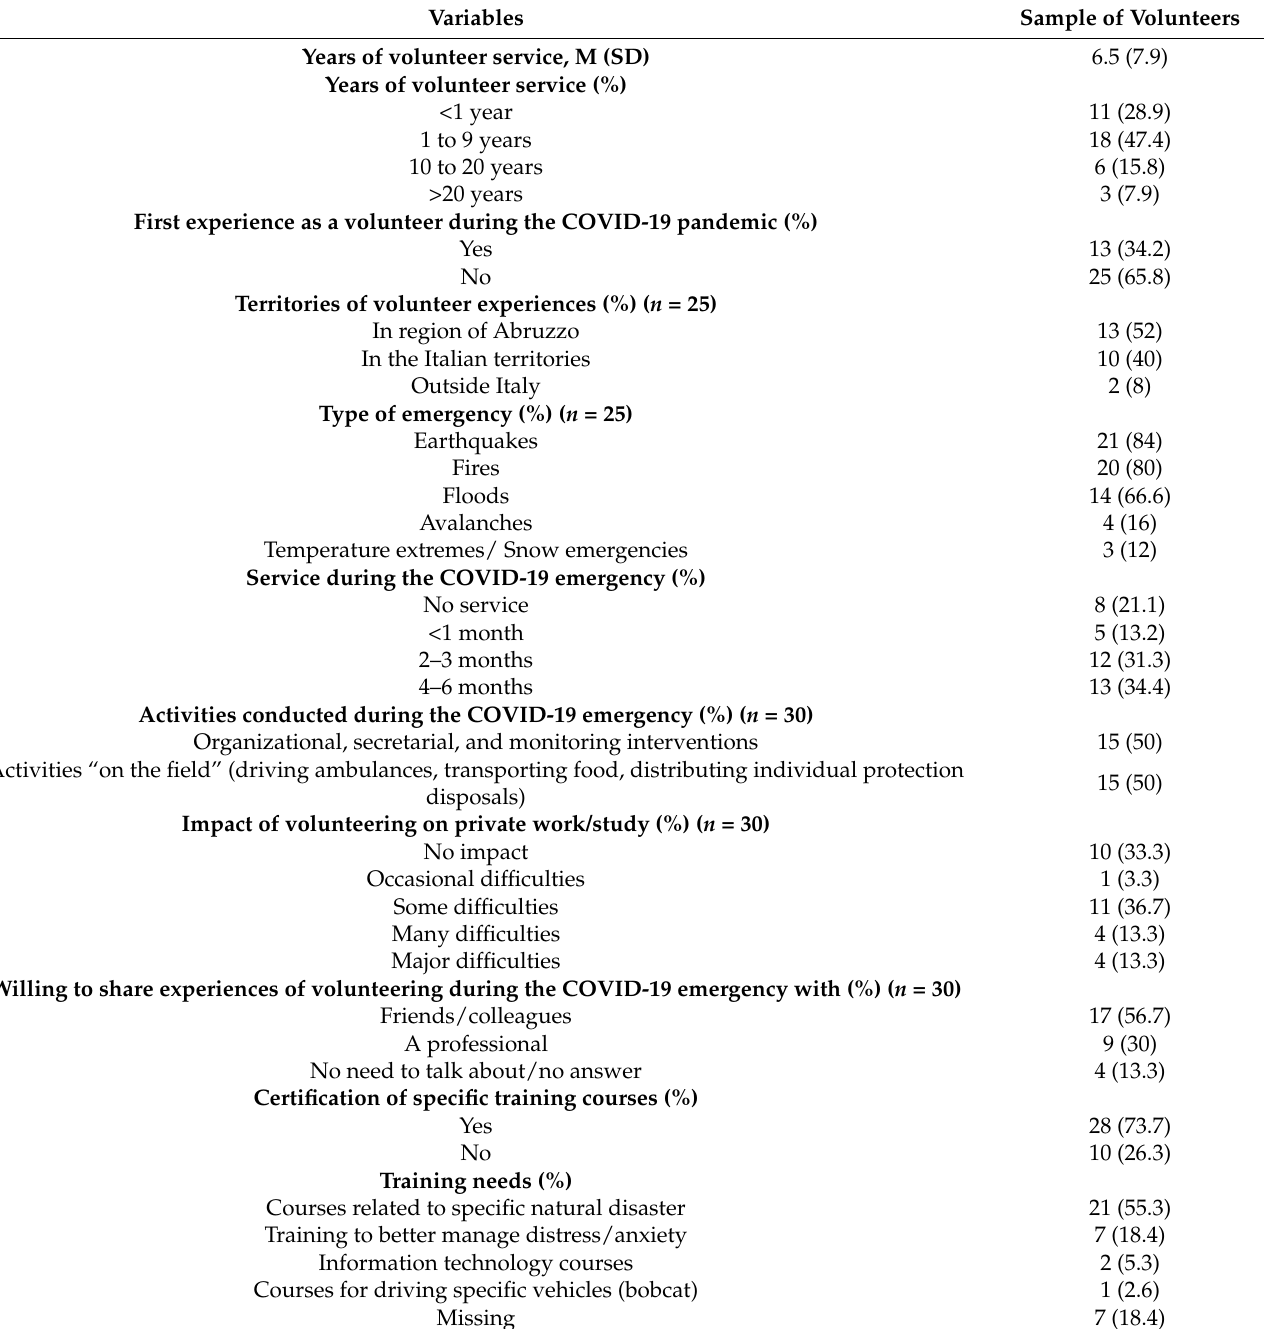
Table 3. Experience in the voluntary sector of the sample ( n = 38).